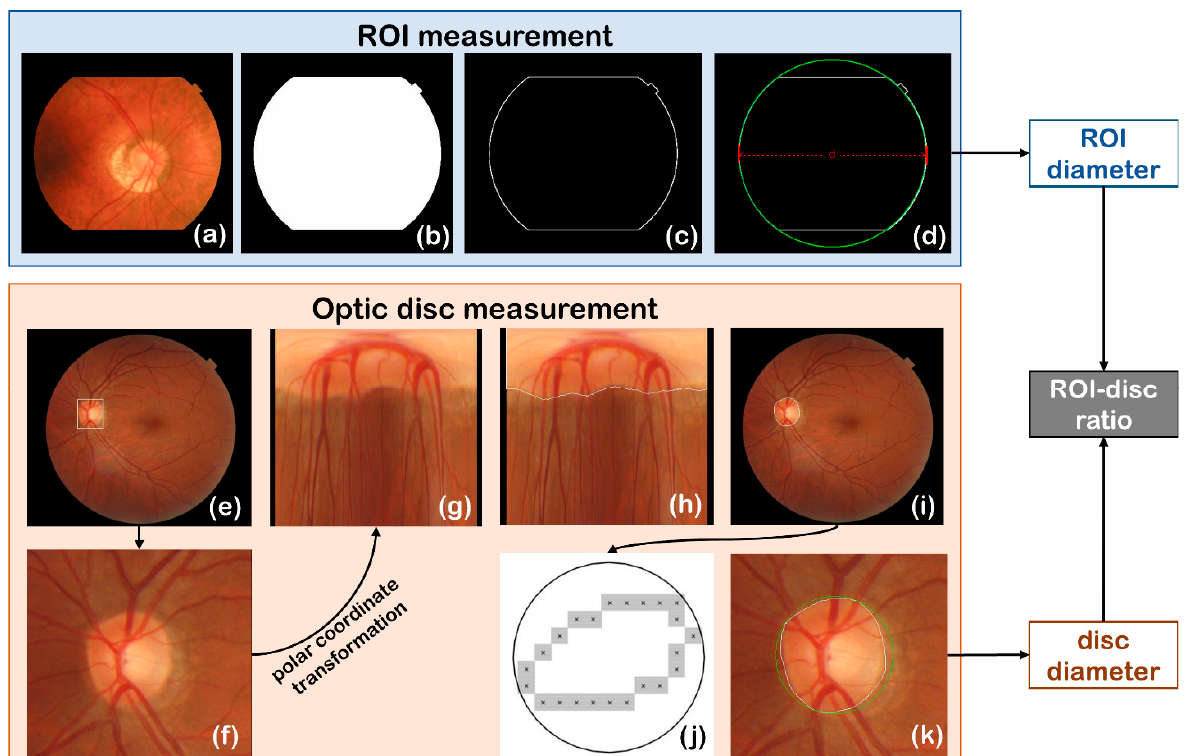
Figure 4. Automated ROI measurement and optic disc measurement. ( a – d ) are the steps of detecting ROI, ( e ) shows the optic disc position target detection box annotation, ( f ) is the detected region of optic disc, ( g – i ) are the steps of disc edge detection in polar coordinate system, and ( j , k ) show the circumscribed circle fitting of the optic disc.